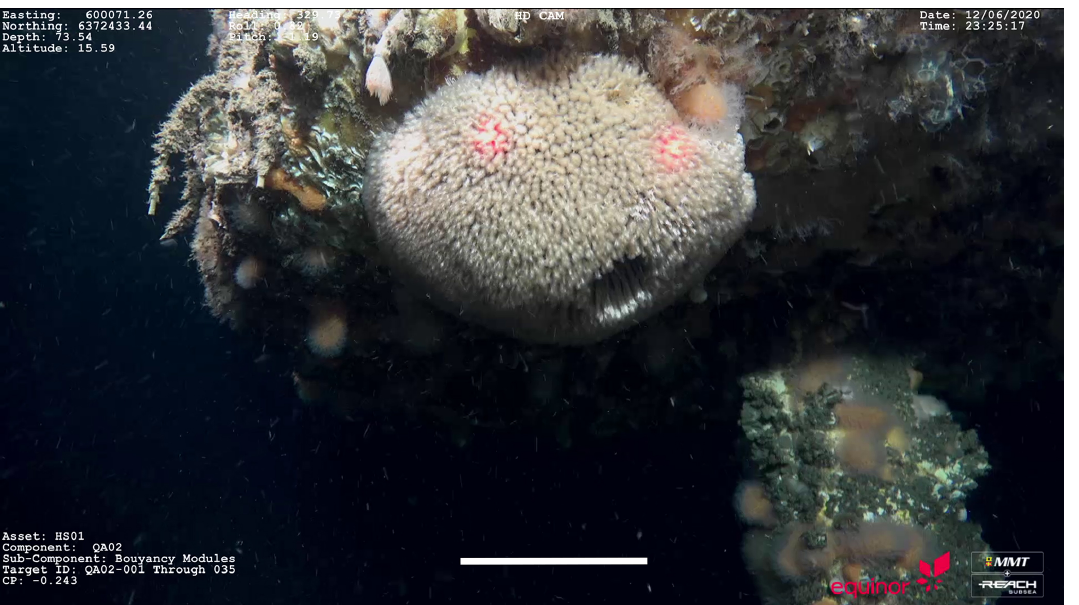
Figure 4. QA02–HS01 buoyancy modules. Possible young colony of D. pertusum . Scale bar: 10cm.